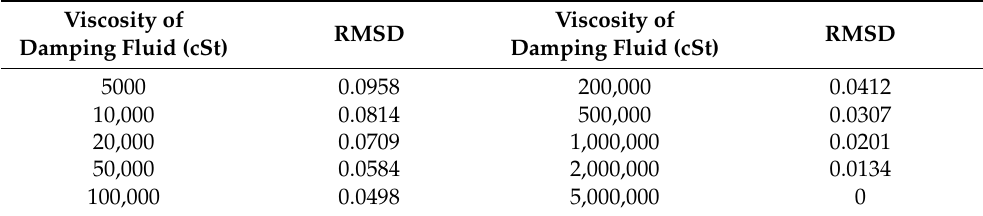
Table 2. Calculation results of RMSD for different damping